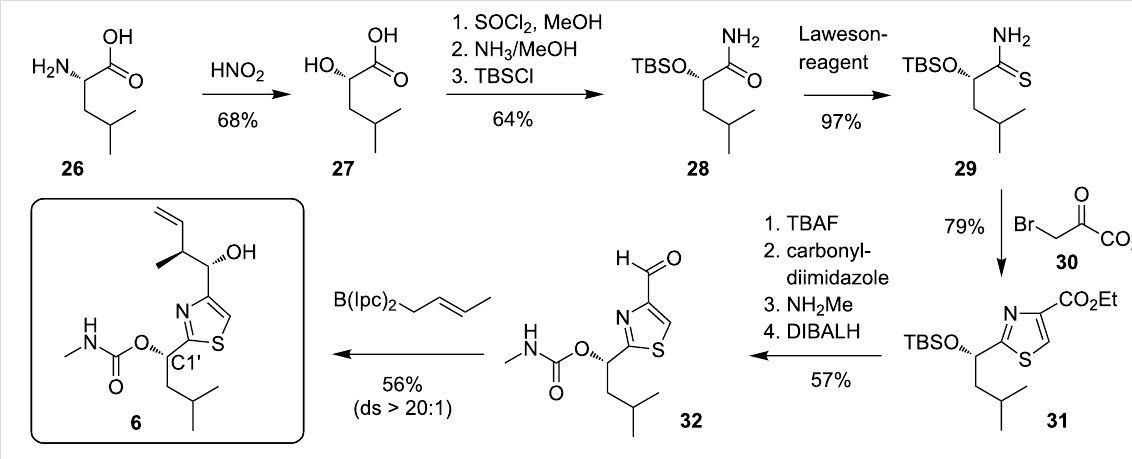
Scheme 5: Thiazol construction and synthesis of the southern fragment 6 .